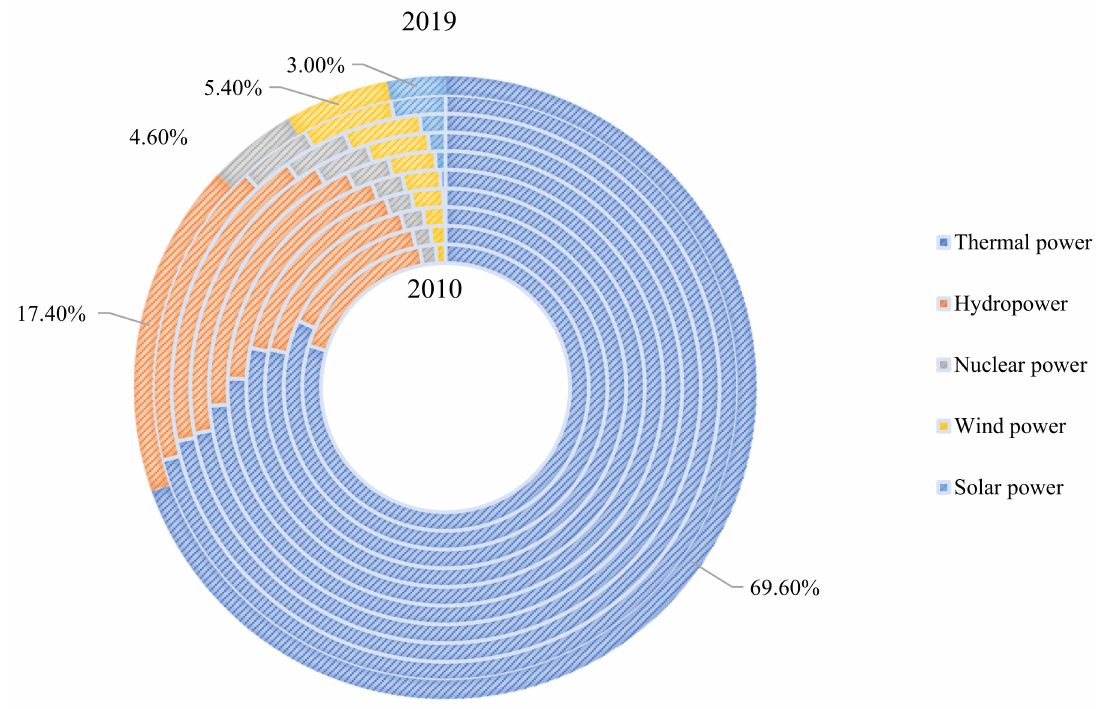
Figure 2. The composition of China’s power generation from 2010 to